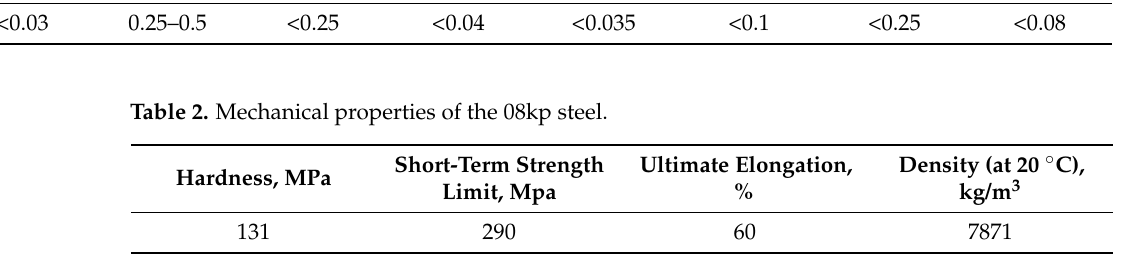
Table 1. Chemical composition of 08kp steel, wt %.